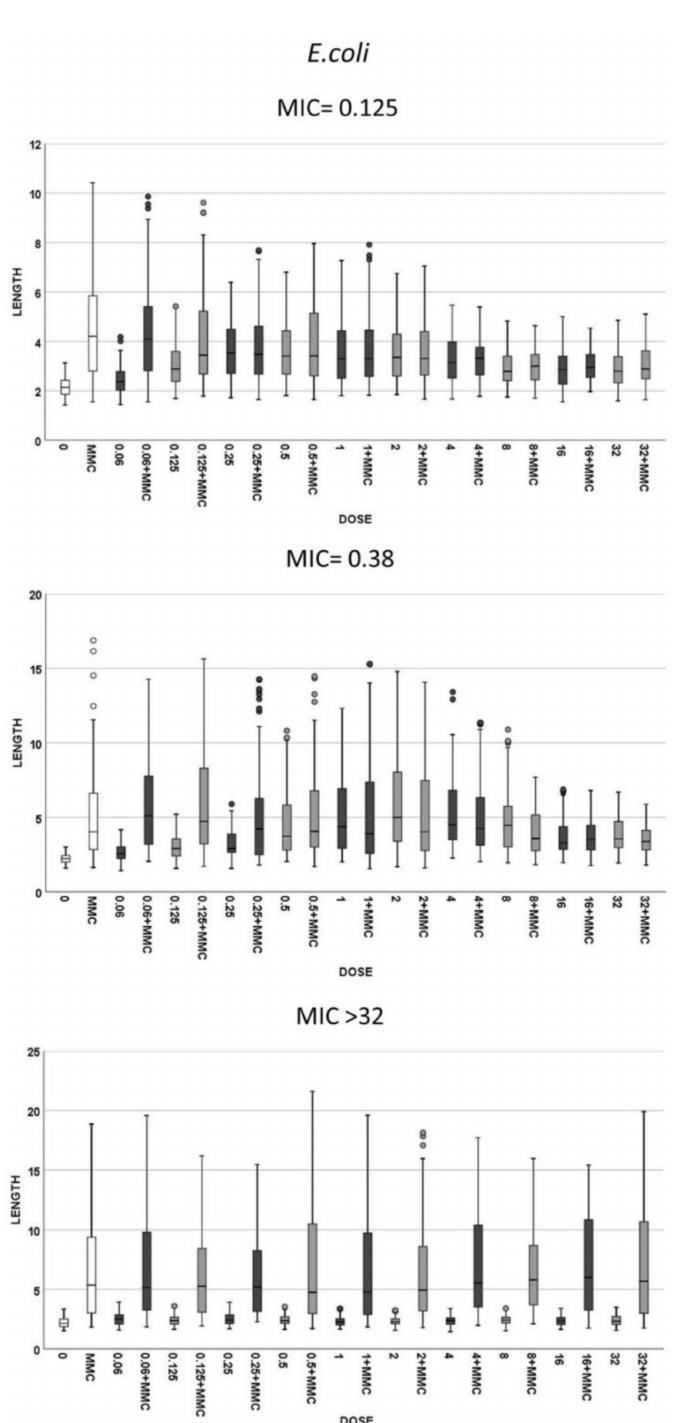
Figure 3. Cell length measures ( µ m) of E. coli in the same strains that were presented in Figure 2. The first and second graphics correspond to the strains susceptible to cotrimoxazole, with MIC 0.125 and 0.38 mg/L, respectively, and the third is a resistant strain with MIC > 32 mg/L. Each strain shows the cell length (vertical axis) in, from left to right (horizontal axis), control cultures (0), cultures incubated with 0.5-mg/L mitomycin C (MMC) and cultures incubated with increasing doses of cotrimoxazole alone, each paired with incubation of cotrimoxazole together with 0.5-mg/L